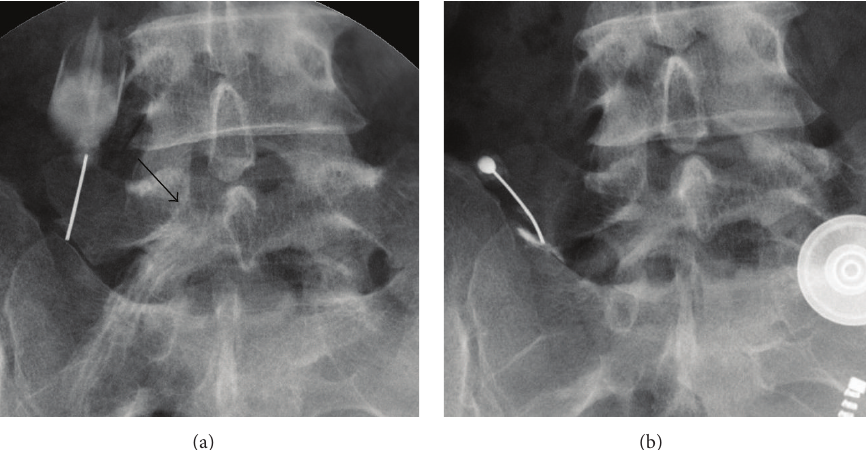
Figure 3: Selective radiculograph of the left L5 nerve root and local injection into the gap between the left transverse process and sacral ala (a) showing impingement of the left L5 nerve root at the lateral recess (arrow) and no impingement in the articulation region. The effectiveness of local injection into the gap between the left transverse process and sacral ala was reconfirmed